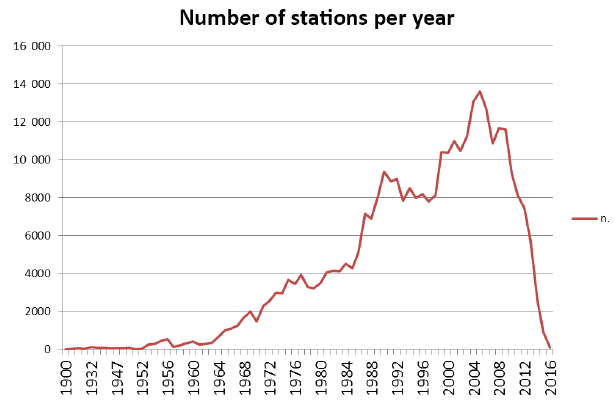
Figure 4. Temporal distribution of nutrient data, spanning from 1900 to 2016 (counting 90 profiles in the current year; updates May